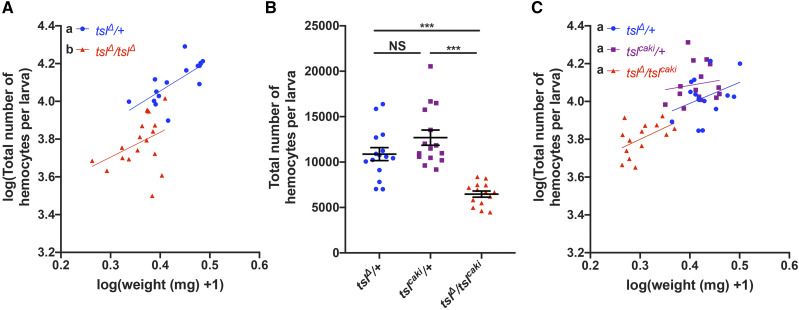
The reduced hemocyte number in tsl mutants is the result of larval growth impairment. (A) Quantification of weight and total hemocyte number (hmlΔ-dsRed) in individual wandering tslΔ/tslΔ and tslΔ/+ larvae. While a relationship exists between total hemocyte number and weight, for any given weight tslΔ/tslΔ mutant larvae have fewer hemocytes than their heterozygous counterparts. (B) Analysis of wandering tslΔ/+, tslcaki/+ and tslΔ/tslcaki larvae (hmlΔ-dsRed) reveals that wandering tslΔ/tslcaki larvae have significantly fewer hemocytes than both heterozygous controls (P < 0.001, n ≥ 14). (C) Data from (B) incorporating larval weights shows that tslΔ/tslcaki larvae have fewer hemocytes than their heterozygous counterparts because they weigh less. For (A) and (C) regression lines that cannot be represented by the same line of best fit are indicated by different lowercase letters. NS, not significant, *P < 0.05, **P < 0.01, ***P < 0.001, Mann-Whitney test. Data points are individual larvae with the means ± 1 SE indicated.